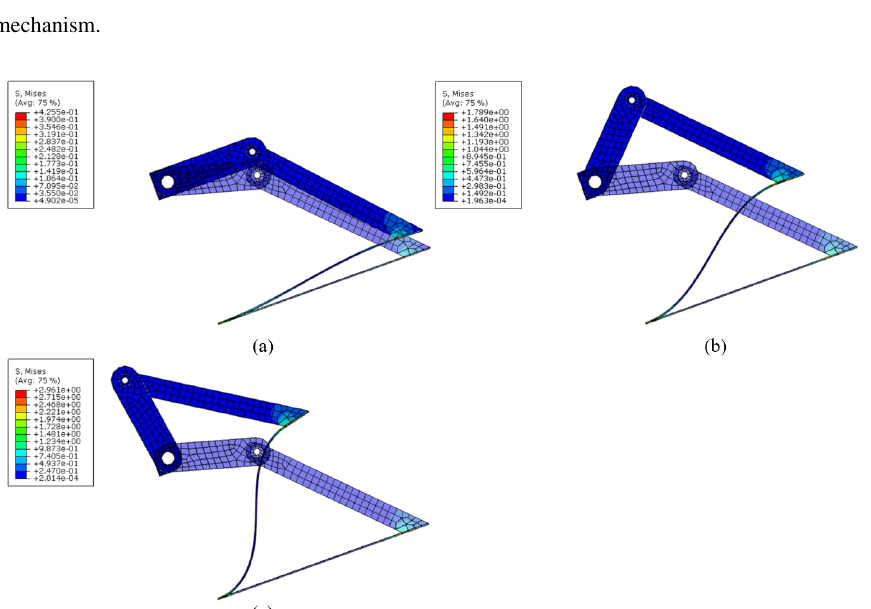
Figure 15. Deformation of the flexure beam. (a) E 1 . (b) E 2 . (c) E 3